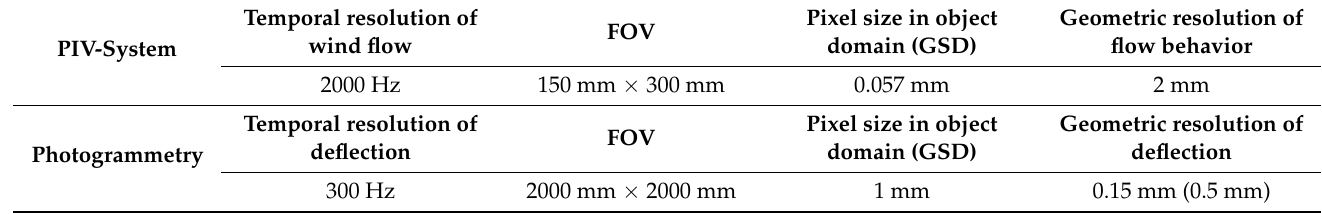
Table 2. Properties of the measurement setup.